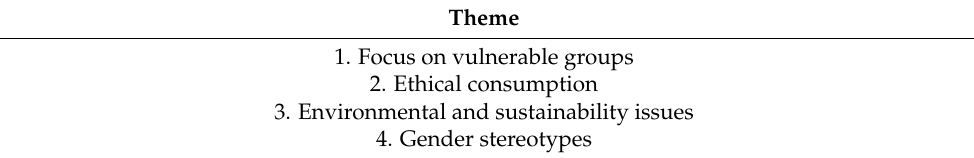
Table 4. Missing and Underrepresented Themes in Financial Education Projects in